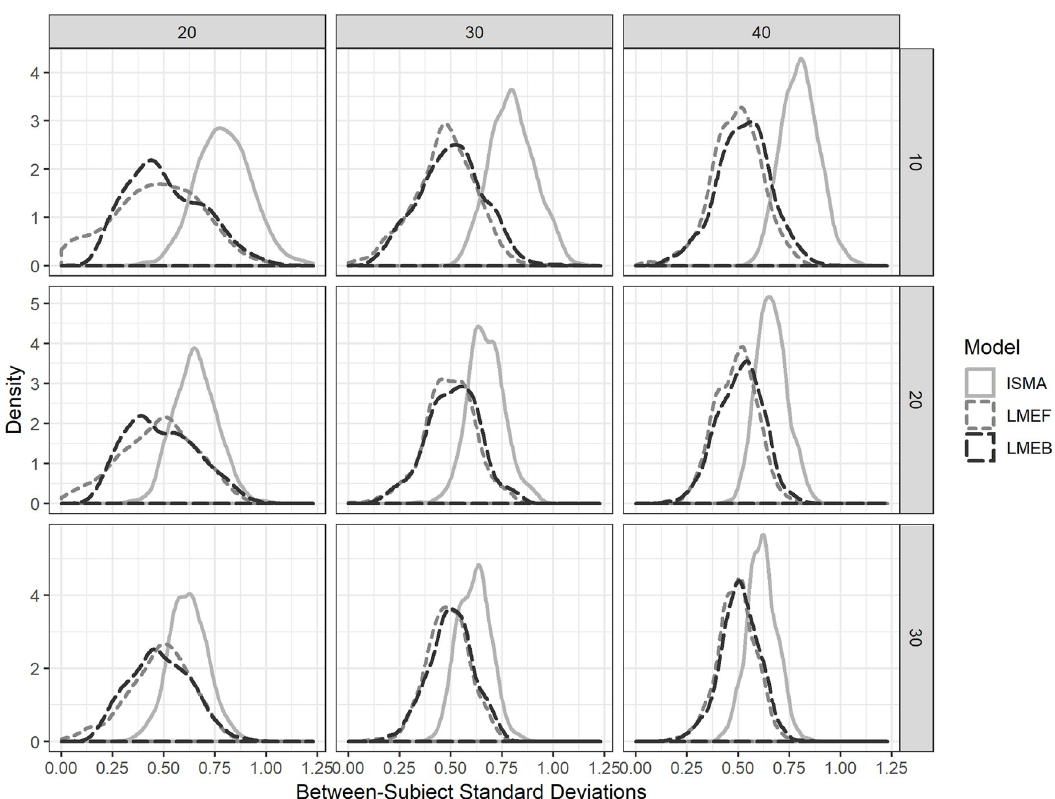
Fig 3. Empirical distributions of the 1,000 replications of the estimated between-subject standard deviations of the treatment effects for the individual-subject meta-analysis (ISMA) the frequentist mixed model (F-LME) and the Bayesian mixed model (B-LME) by number of subjects (columns; 20, 30 or 40 subjects) and number of measurements per subject (rows; 10, 20, or 30 measurements per condition). The average of the simulated true value of the standard deviation is 0.5.